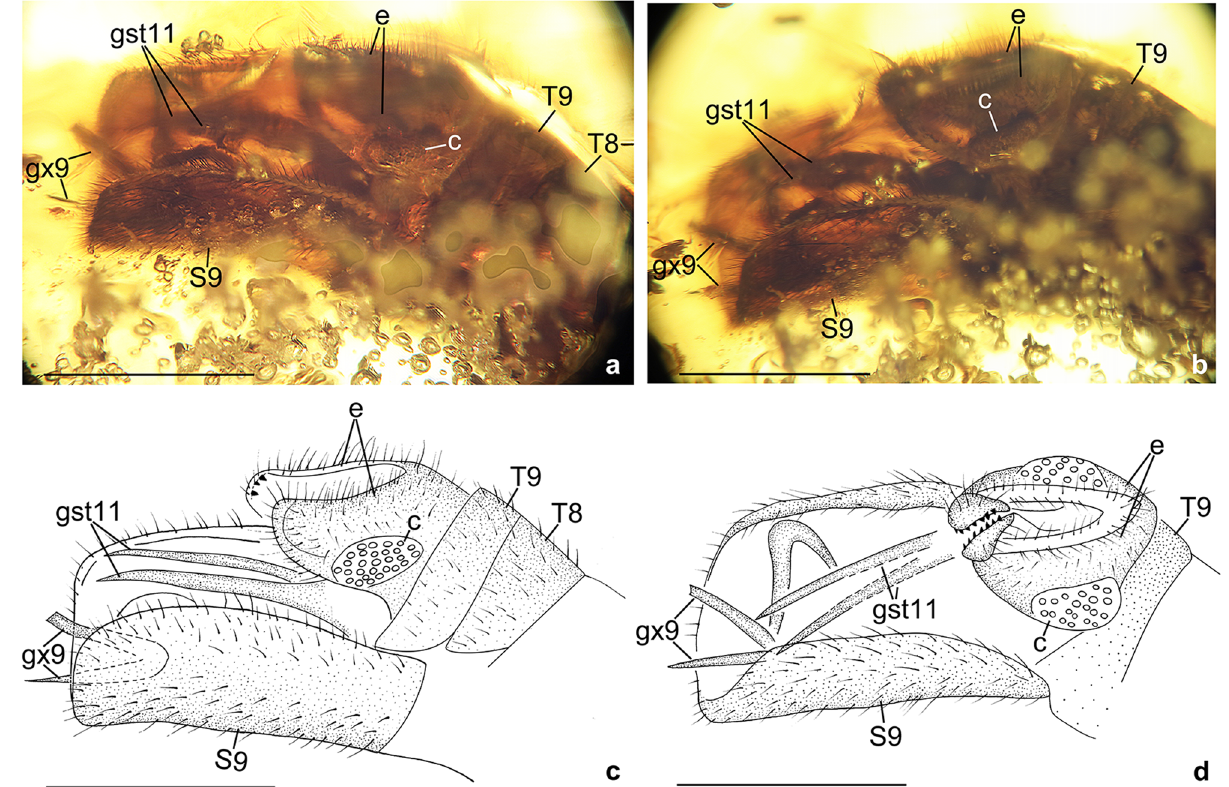
Figure 6. Stenobabinskaia punctata sp. nov., holotype male. (a ) photograph of genitalia, lateral view; ( b ) photograph of genitalia, dorsal view; ( c ) drawing of genitalia, lateral view (drawn by XML); ( d ) drawing of genitalia, dorsal view (drawn by XML). Scale bar = 1.0